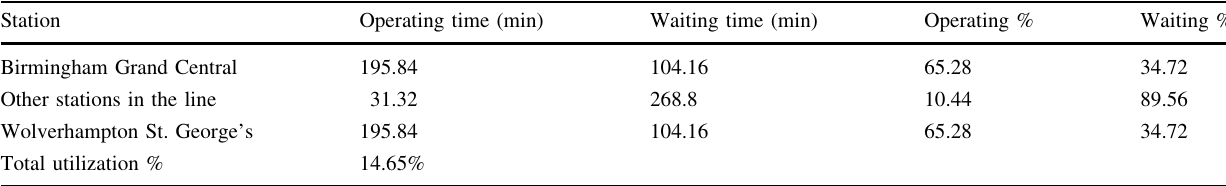
Table 9 Operating and waiting times of the rail system during peak hours in anticlockwise direction